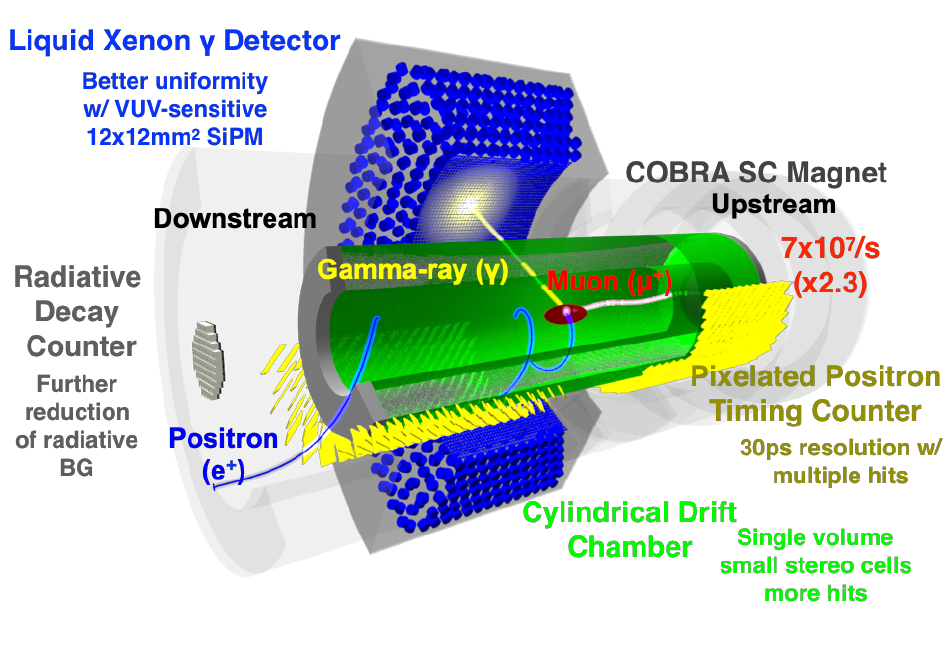
Figure 3: Drawing of the MEG II